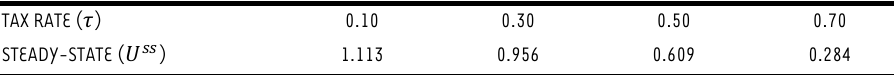
The effect of the tax rate on welfare TAX RATE